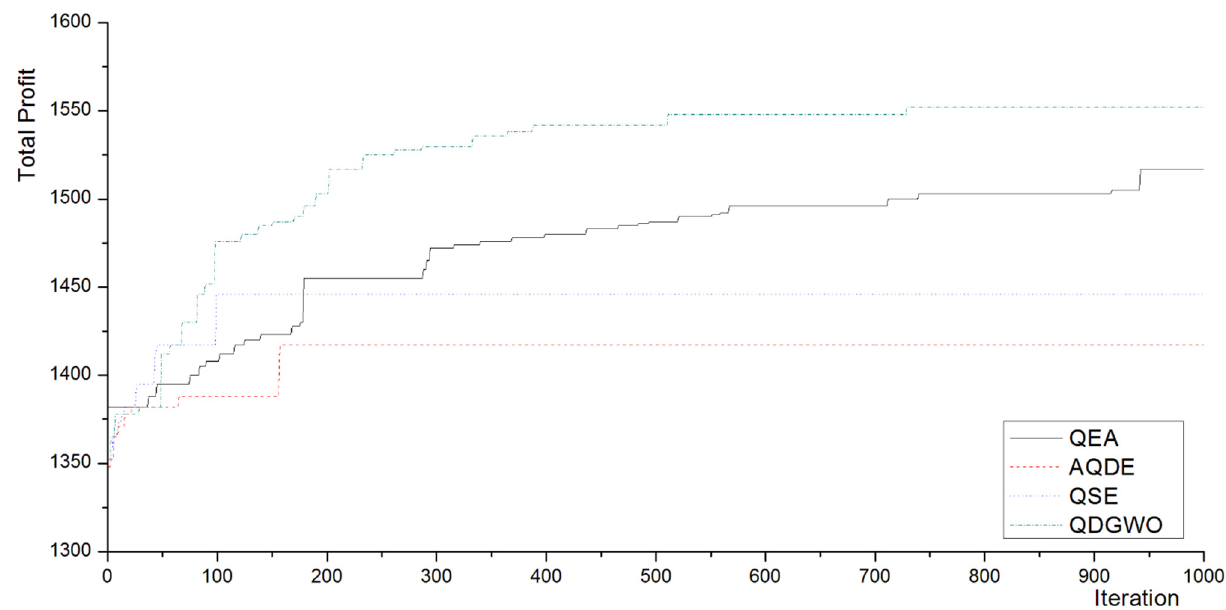
Figure 4. Best profits for the 0-1 knapsack problems (250 items in Experiment 1).